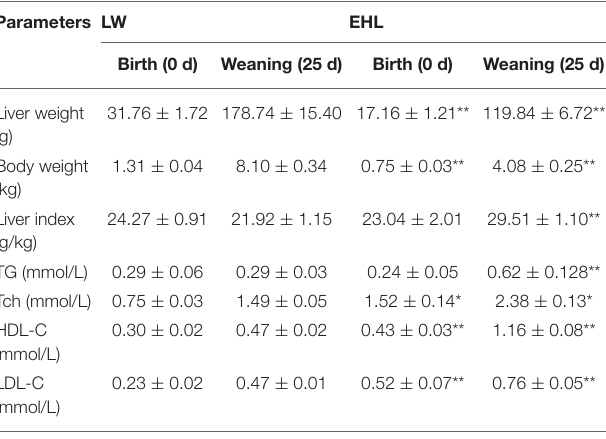
TABLE 2 | Body weight, liver weight, liver index, and the content of cholesterol in serum and liver of the offspring piglets at birth and weaning ( n = 6 piglets each time point per